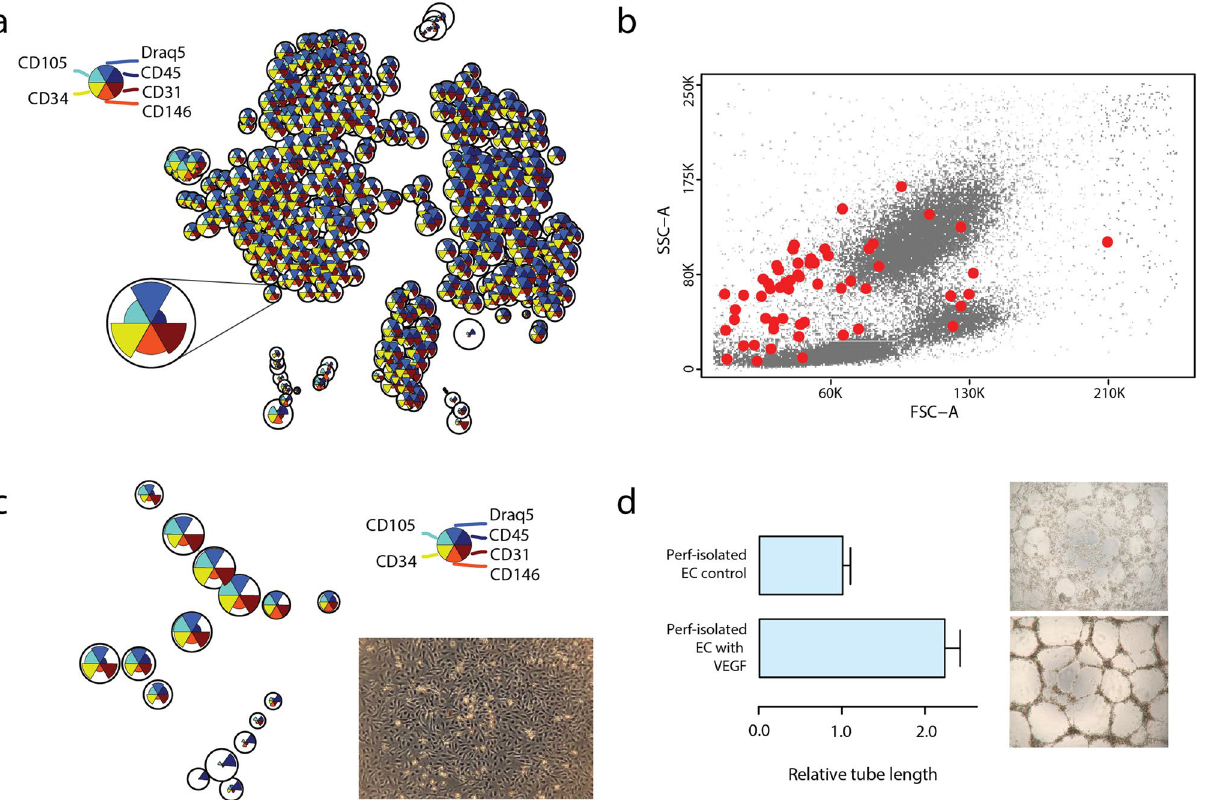
Figure 1. Identification of EC in kidney perfusates. Perfusate cells were stained for CD45, CD31, CD34, CD146, CD105, and Draq5. EC were identified by non-biased clustering. (a) t-SNE representation of cell clusters; cluster size indicates amount of cells; pie charts inside clusters depict the mean fluorescence intensities (MFIs) of the indicated markers in the cluster. The EC cluster is magnified. (b) Dot plot depicting cells in perfusion solution, EC are marked with red dots. (c) Cells isolated from perfusates on the basis of their morphology and subsequently expanded showed EC immunophenotype and typical cobblestone morphology. (d) Branching network forming capacity upon stimulation with VEGF. The tube length in three randomly chosen fields from each well was measured. Data is expressed as mean of 4 experiments ±